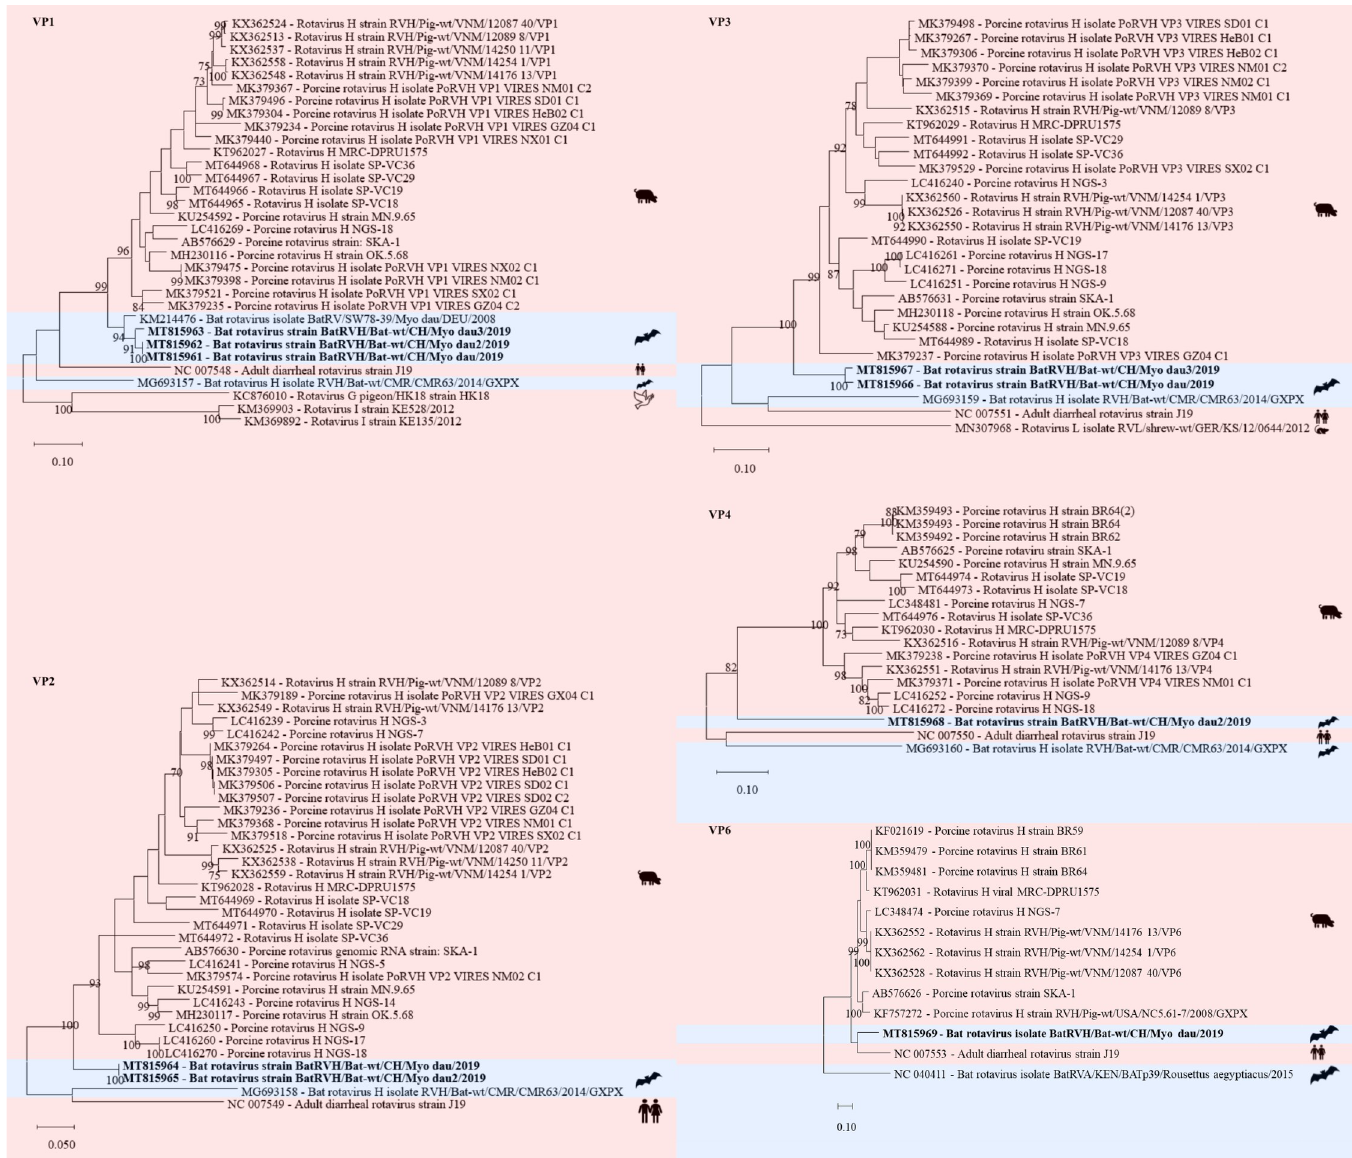
Fig 6. Phylogenetic analysis of specific regions of the rotavirus H genome. The sequences obtained in this study (GenBank acc. numbers MT815961-69) are shown in bold. Sequences of non-bat associated viruses are marked with a red background and those of bat associated viruses with a blue background. The pictograms on the right side represent the species in which the virus was detected. Sequences were aligned using Muscle. For phylogenetic analysis, the Maximum likelihood tree with 1’000 bootstraps was used. Only values � 70% are